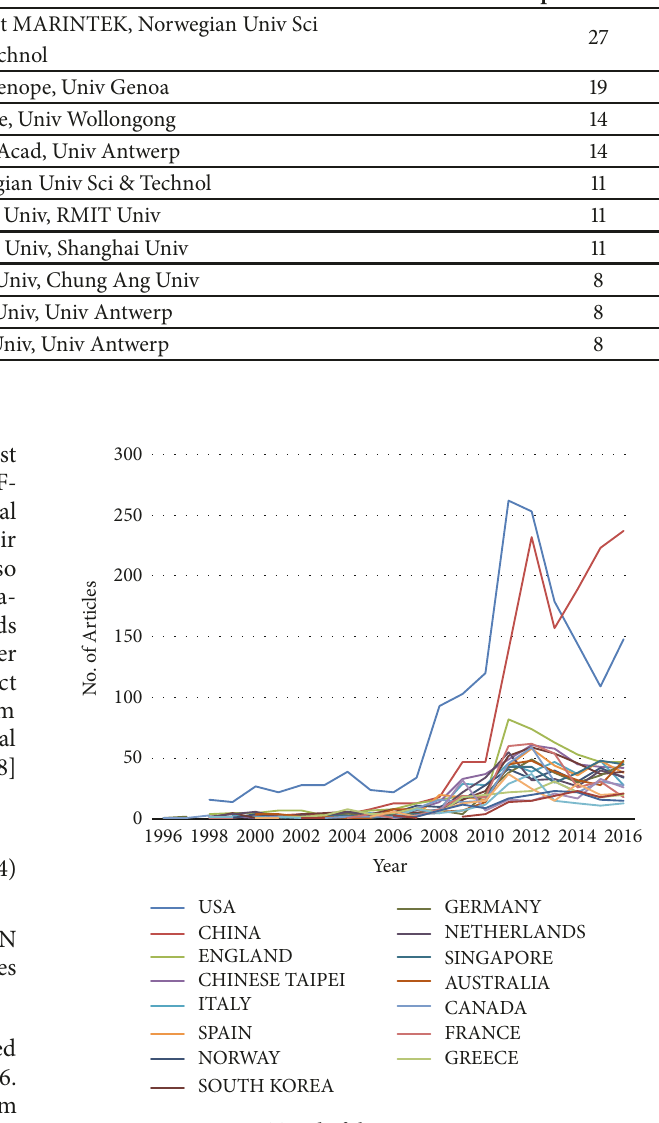
Figure 2: Trend of the